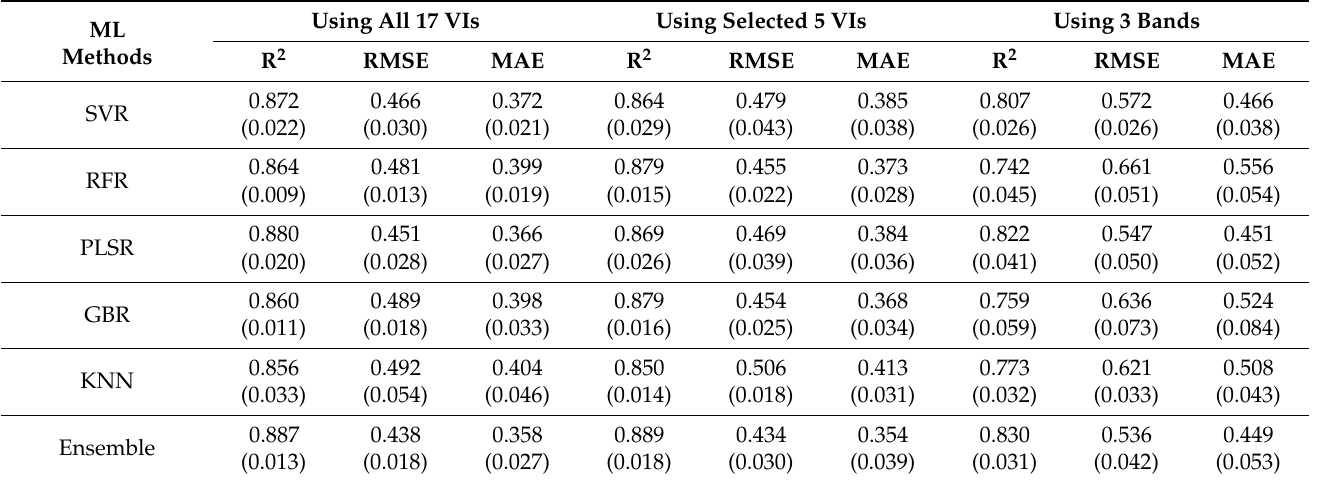
Table 5. Test accuracies including mean and standard deviation of five base models and an